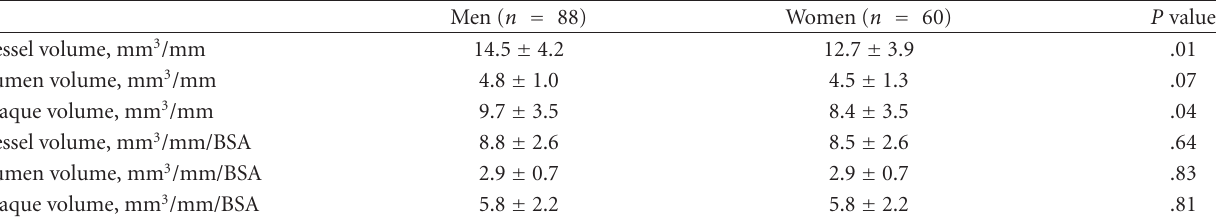
Table 2: Grey-scale IVUS analysis.